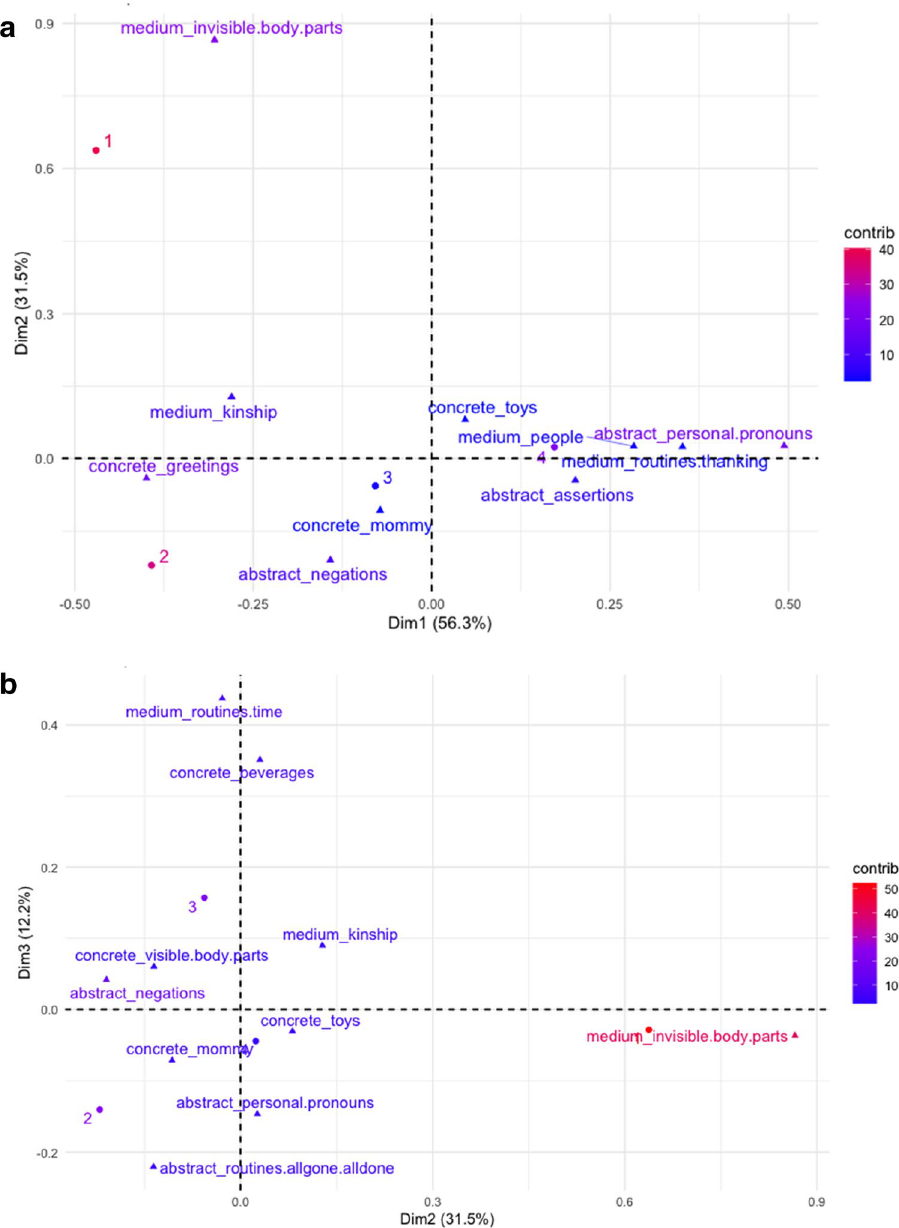
Figure 7. ( a ) Symmetric plot of Dimensions 1 and 2, with points distribution and their contribution on dimensions. Only the top 10 contributing columns (subcategories of concepts) are shown. Rows are represented by circles and columns by triangles. The distance between row points or column points represents their relation. Closer points are more similar to each other than more distant points. ( b ) Symmetric plot of Dimensions 2 and 3, with points distribution and their contribution on dimensions. Only the top 10 contributing columns (subcategories of concepts) are shown. Rows are represented by circles and columns by triangles. The distance between row points or column points represents their relation. Closer points are more similar to each other than more distant